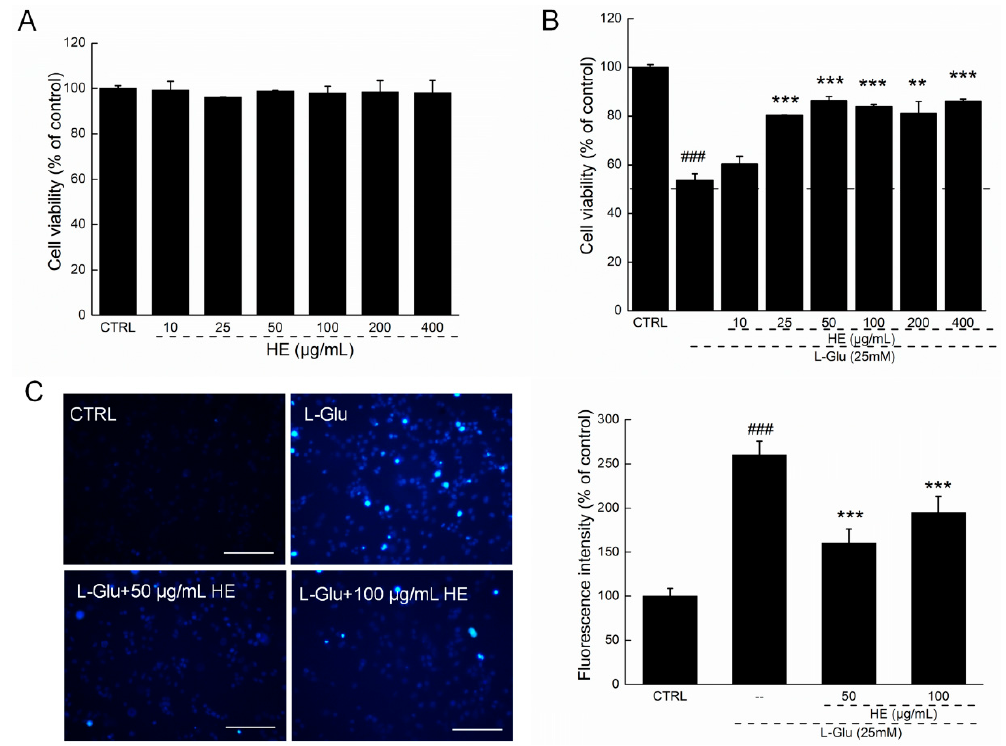
Figure 2. ( A ) HE showed no effects on cell proliferation in normal DPC12 cells; ( B ) but strongly enhanced cell viability in L -Glu-induced DPC12 cellular apoptosis model; ( C ) HE restored L -Glu-induced nucleus morphological apoptotic alterations analyzed via Hoechst 33342 staining ( n = 6). Scale bar: 100 µm. HE: Hericium erinaceus aqueous extract. Data are expressed as mean ± SD ( n = 6). ### p < 0.001 vs. CTRL, ** p < 0.01 and *** p < 0.001 vs. L -Glu-exposed cells. HE: Hericium erinaceus aqueous extract; CTRL: Non-treated cells.